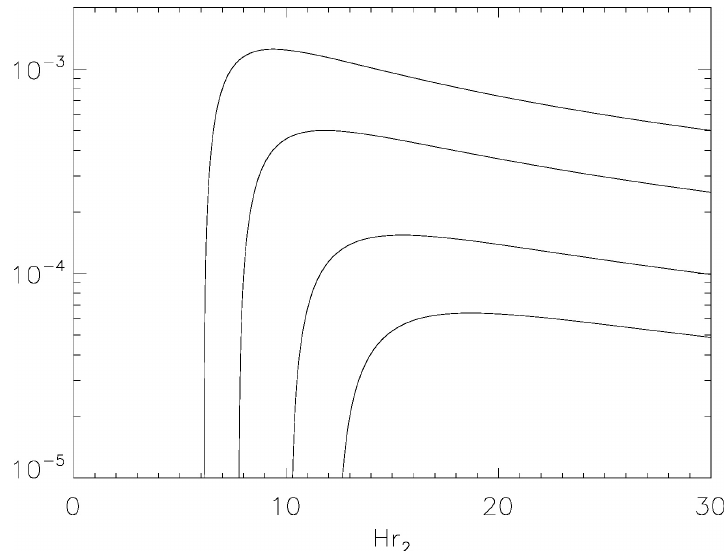
Figure 2 . The velocity correlation function is plotted as a function of H r 2 for H r b = 0 . 1 and H r c ≈ 0 . 946 . The curves from top to bottom correspond to H r 1 being fixed at 0 . 9 Hr c , 0 . 95 Hr c , 0 . 98 Hr c , and 0 . 99 Hr c respectively. Since the purpose of this figure is to illustrate the changes in size and location of the peaks as the value of r 1 changes, only the parts of the curves with r 2 > r 1 and g ( r 1 , r 2 ) > 0 are